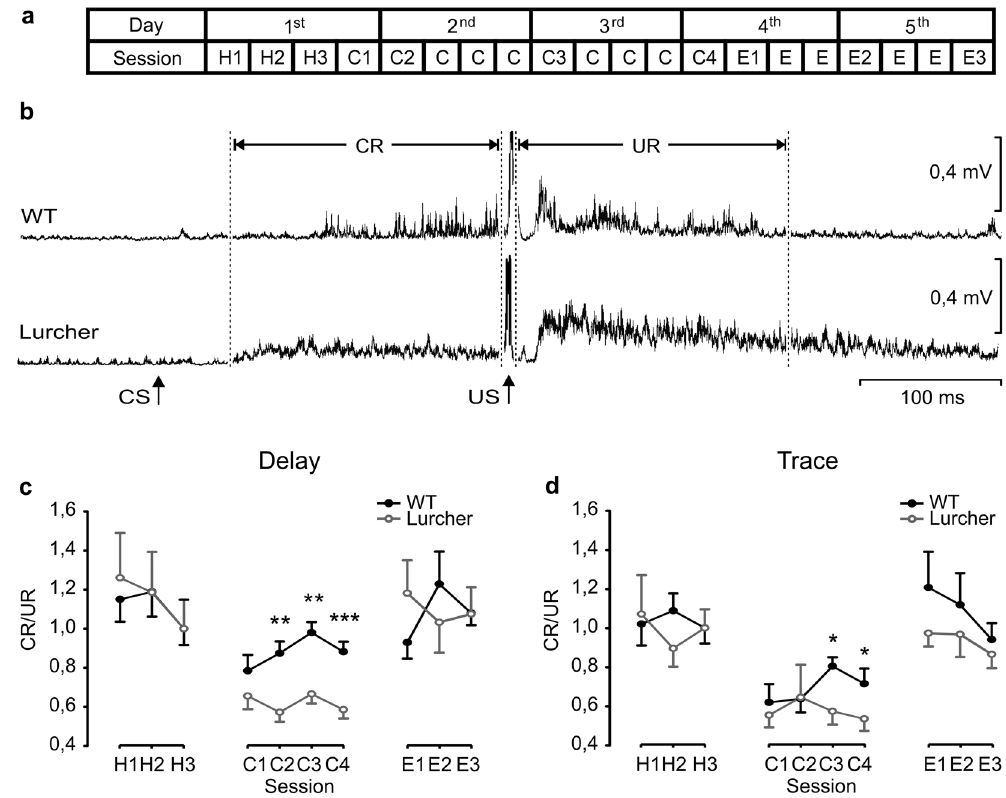
Figure 4. Evolution of classical eyeblink conditioning of WT and Lurcher mice. ( a ) Schematic representation of habituation (H), conditioning (C), and extinction (E) sessions, using both delay and trace conditioning paradigms. Each of the five (1st to 5th) training sessions consisted of 200 trials, divided in four sessions of 50 trials each. Sessions analyzed to obtain learning curves, shown in ( c ) and ( d ), are indicated by numbers (H1- H3, C1-C4, and E1-E3). ( b ) rEMG averaged from 50 trials from a C4 session of representative WT and Lurcher mice. CS and US presentations, and the CR and UR sections whose areas were quantified for the formulation of the learning curves shown in ( c ) and ( d ) are indicated. ( c , d ) CR/UR ratios of rEMG areas collected from WT and Lurcher mice during delay ( c ) and trace ( d ) conditioning paradigms. Represented data are mean ± SEM of the percentage (%) of CRs (n = 9 animals per group). * P < 0.05; ** P < 0.01. Student-Newman-Keuls post hoc one-way